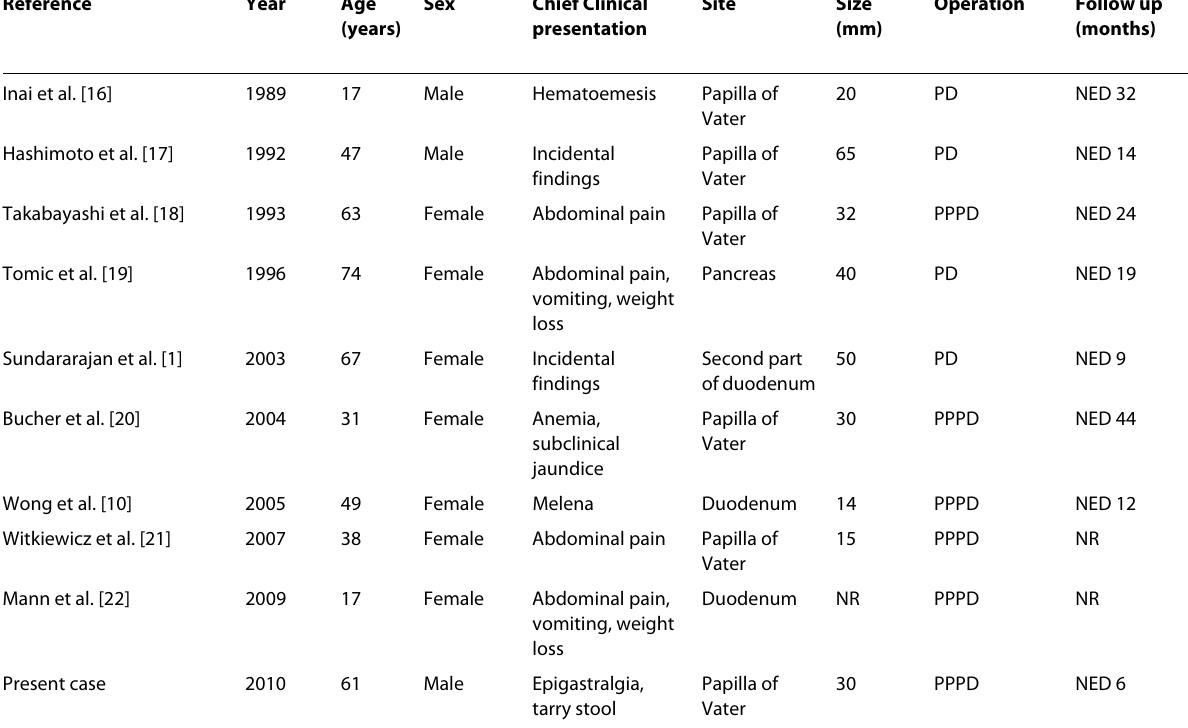
Table 1: Gangliocytic paraganglioma showing lymph node metastasis